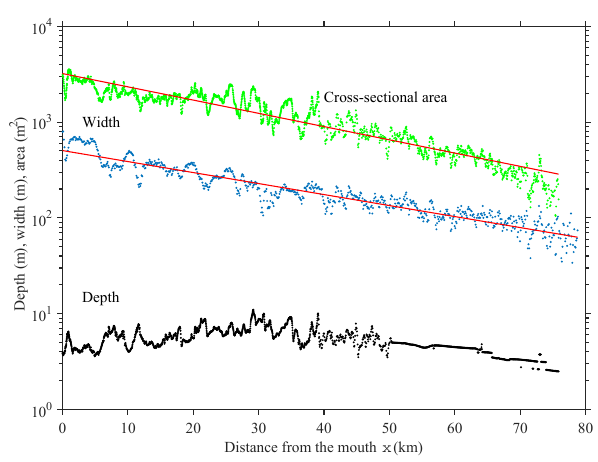
Figure 2. Tidally averaged depth (m, black dots), width (m, blue dots) and cross-sectional area (m 2 , green dots) along the Guadiana estuary. Red lines represent exponential fit curves for the width and cross-sectional